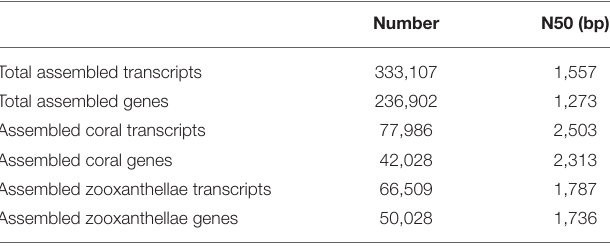
TABLE 2 | Transcript assembly statistics in coral Galaxea fascicularis .